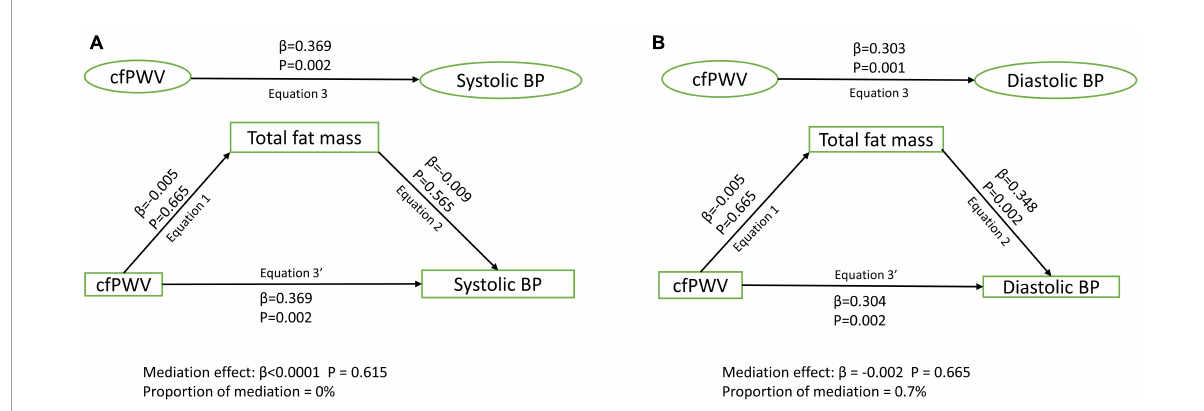
FIGURE1 Mediating role of fat mass on the associations of arterial stiffness with systolic blood pressure (A) and diastolic blood pressure (B) . Mediating path analyses were adjusted for age, sex, high-density lipoprotein cholesterol, low-density lipoprotein cholesterol, triglyceride, high-sensitivity C reactive protein, family history of hypertension and cardiovascular diseases, smoking status, heart rate, insulin, and lean mass. BP, blood pressure; cfPWV, carotid-femoral pulse wave velocity.